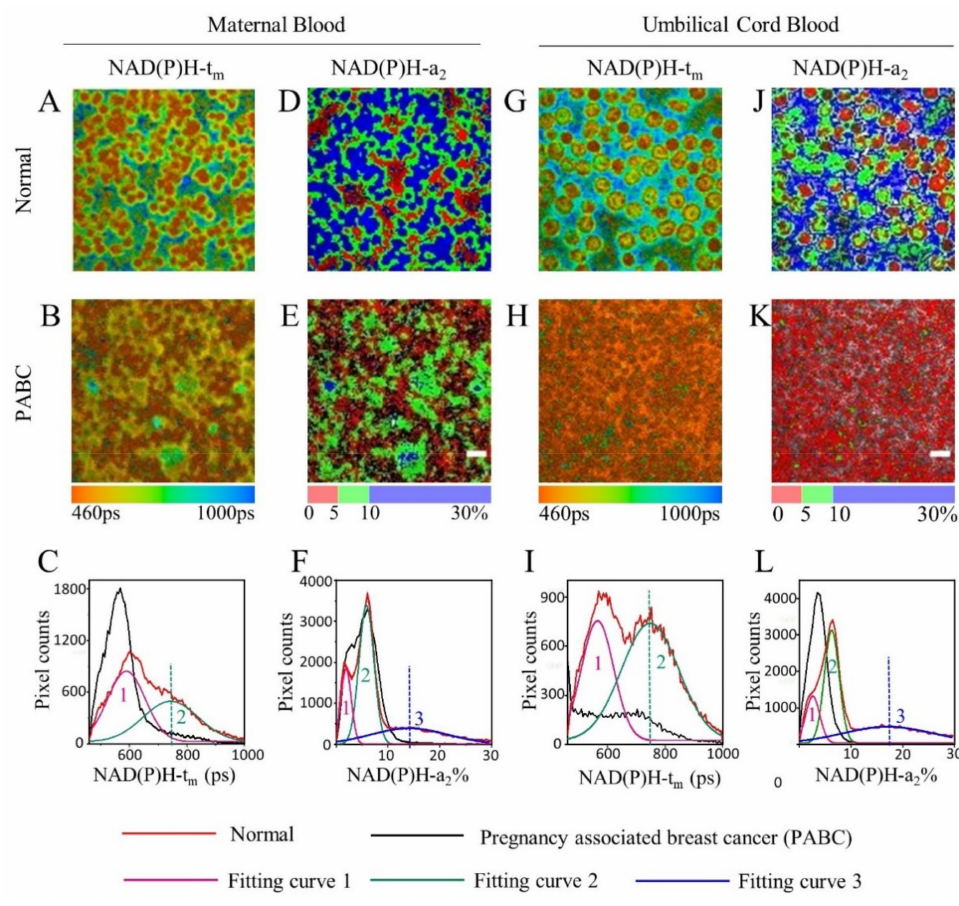
Figure 2. Representative NAD(P)H FLIM images and their distribution curves of normal and PABC cases. ( A , B , D , E ) t m and a 2 images of maternal blood, ( G , H , J , K ) t m and a 2 images of umbilical cord blood. ( C , F , I , L ) Distribution curves of corresponding images. Scale bar: 10 µ m.